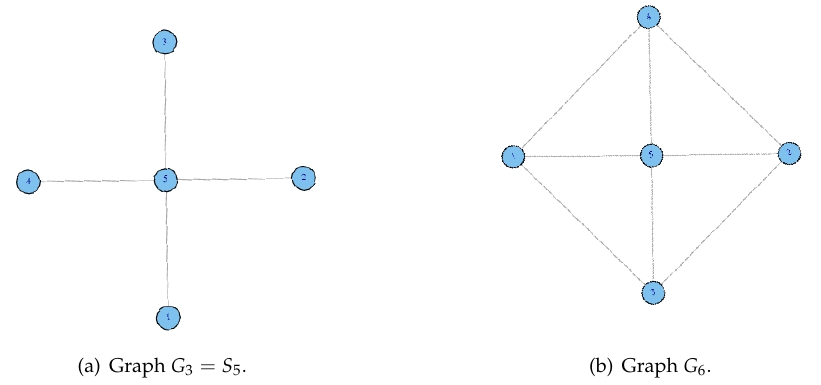
Figure 8. Two networks G 3 = S 5 and G 6 representing different